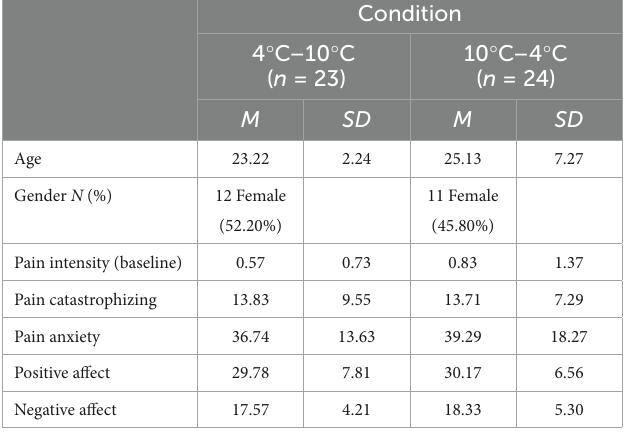
TABLE 1 Descriptive statistics and group difference for baseline